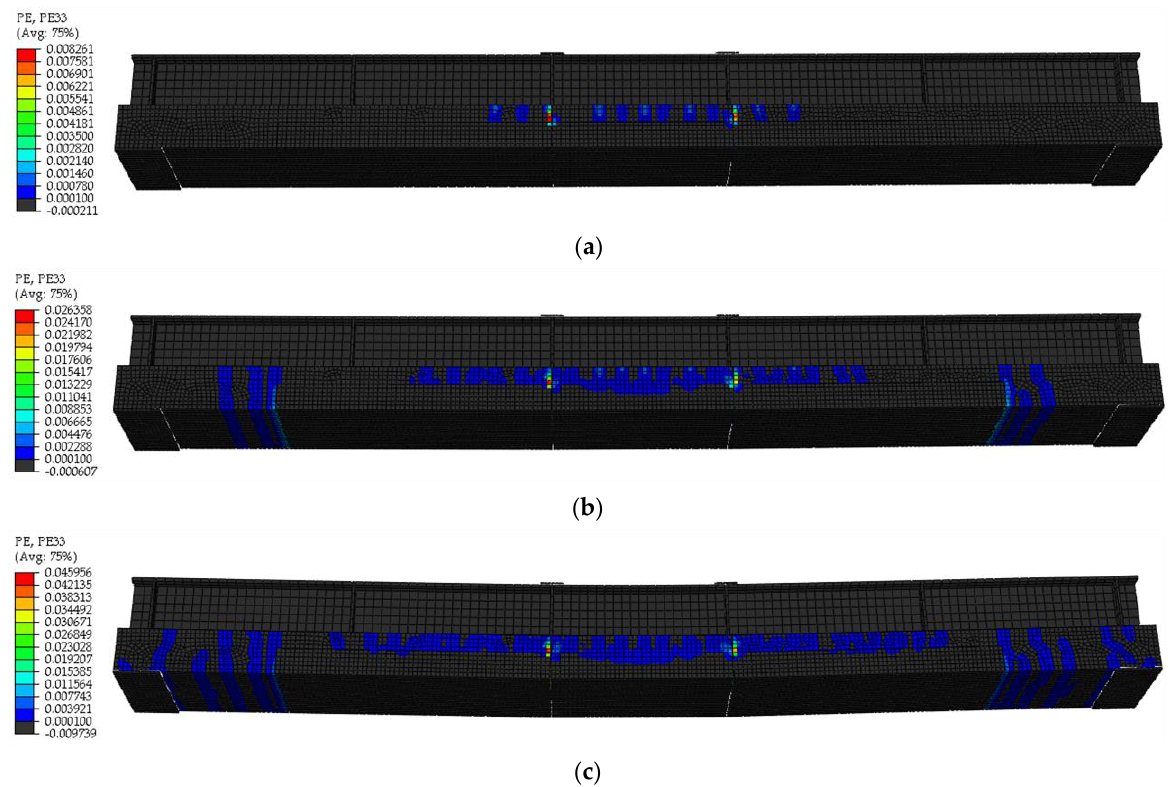
Figure 12. Crack development for a UHPC layer ratio of 0.6: ( a ) applied load equals 120 kN; ( b ) applied load equals 305 kN; ( c ) applied load equals 335 kN. ( b ) applied load equals 305 kN; ( c ) applied load equals 335